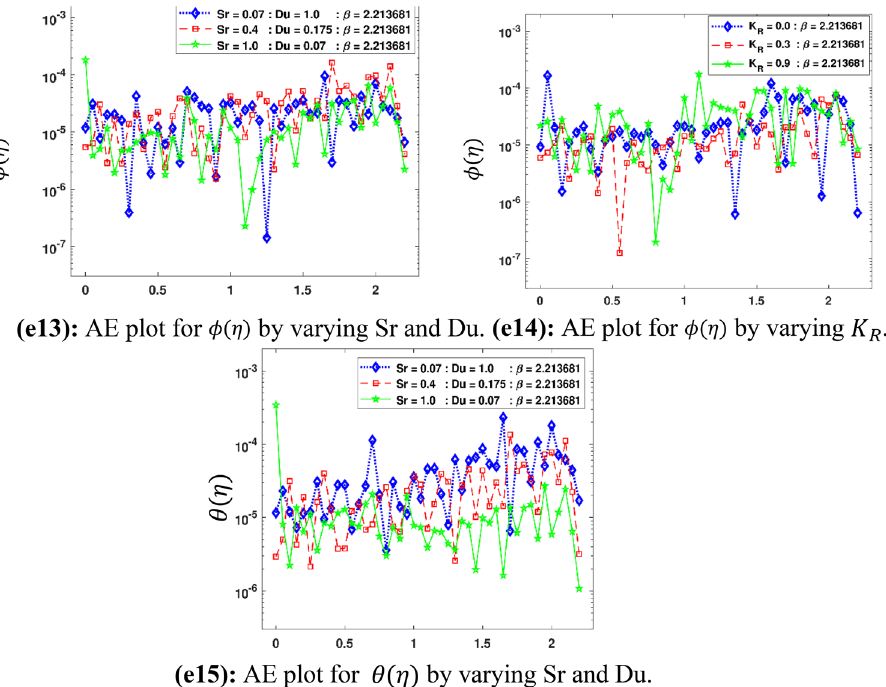
Figure 17. AE plots for outputs by proposed scheme and reference